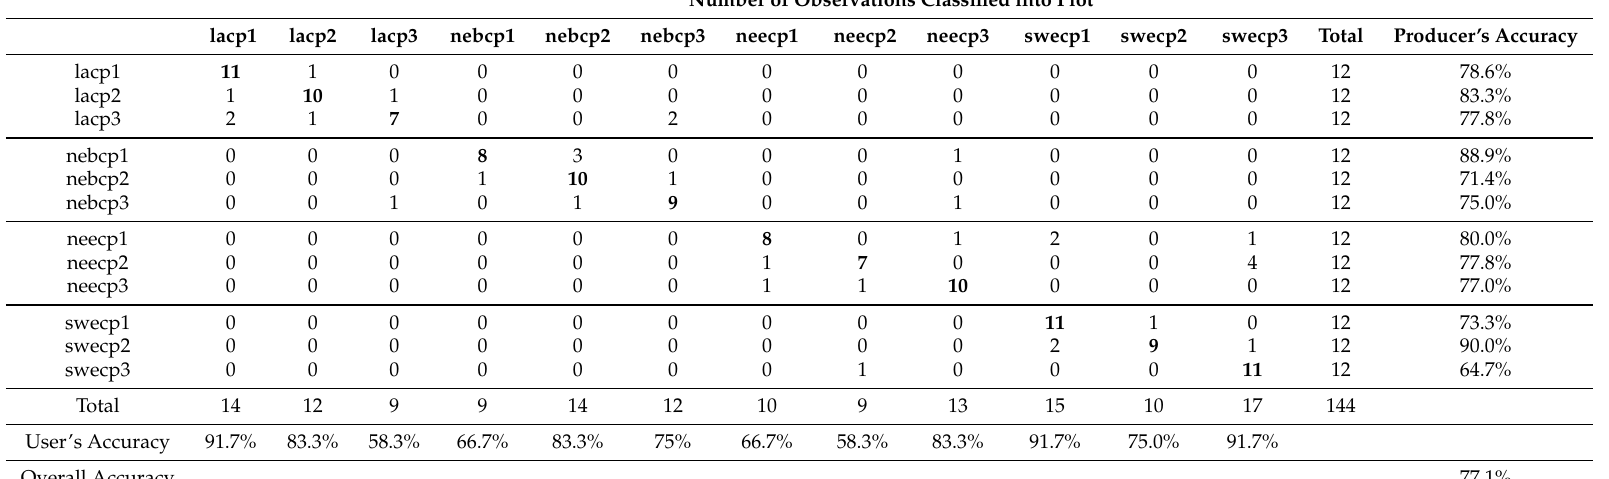
Table 5. Confusion matrix for summer 2014 discriminant analysis to test discriminabilty of plots using wavelengths selected using principal components